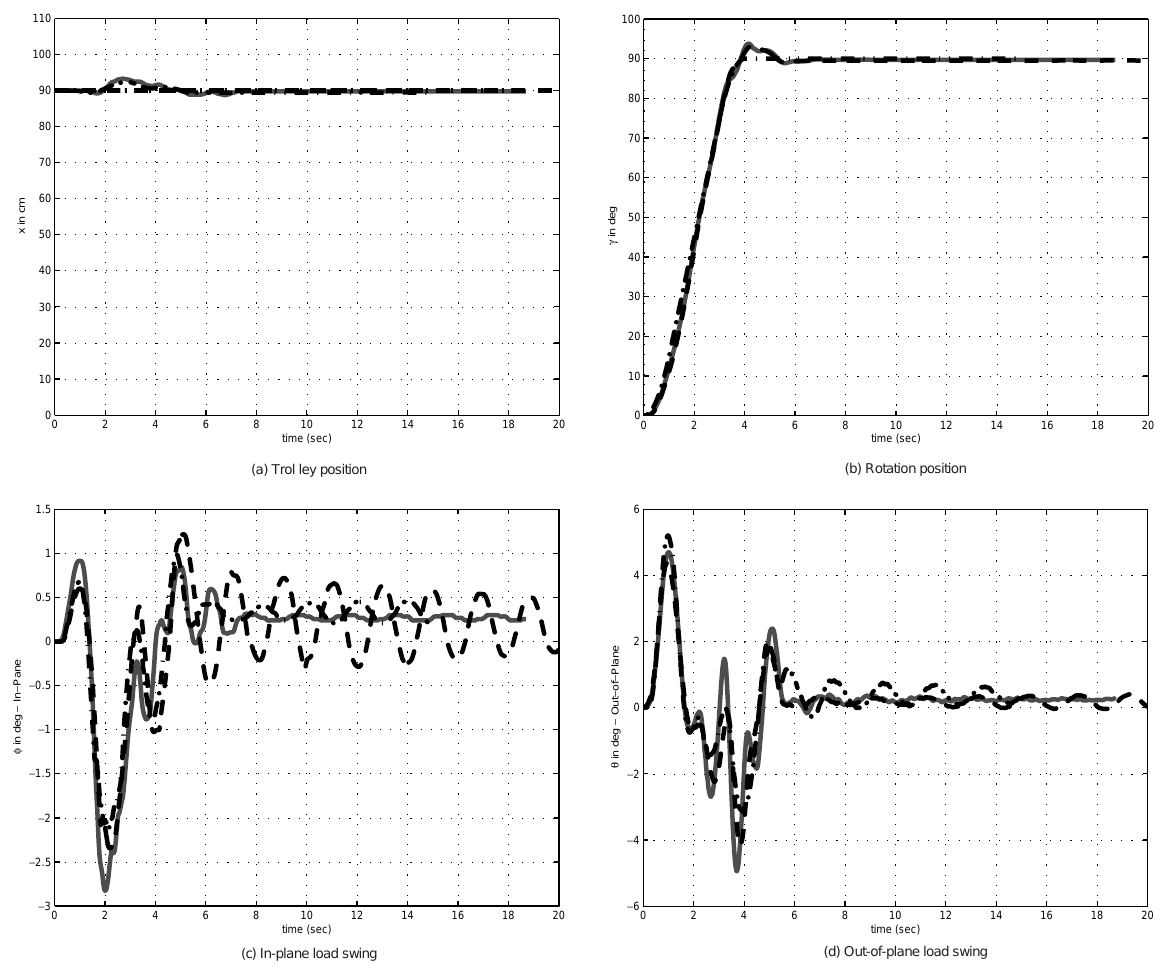
Fig. 14. Time histories of the rotational motion: —— fuzzy with friction compensation, - - - - fuzzy without friction compensation, -.-.-.- delay with friction compensation, and . . . . . reference